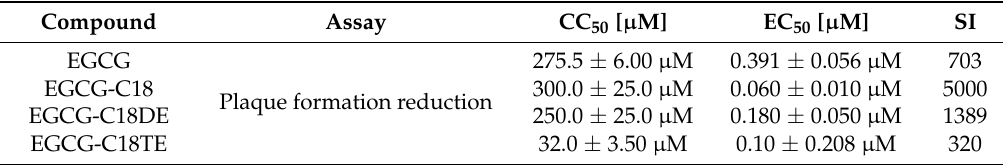
Table 7. Cytotoxicity and Direct Virucidal Effect of EGCG and EGCG-Fatty Acid Derivatives against Influenza A/PR/8/34(H1N1) Virus. Compound Assay CC 50 [ µ M] EC 50 [ µ M] EGCG Plaque formation